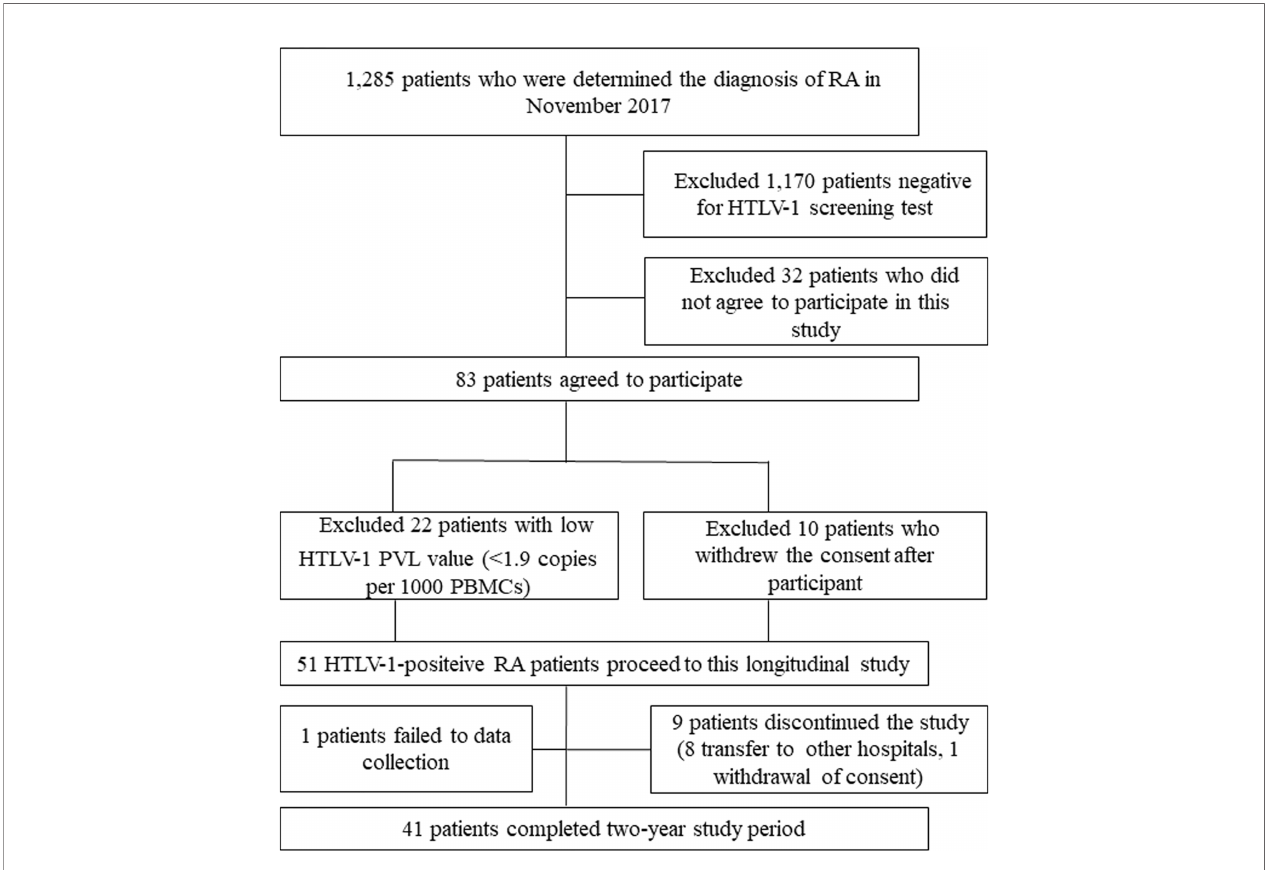
FIGURE 1 | Flowchart for study sample. RA , rheumatoid arthritis; HTLV-1 PVL , Human T-cell leukemia virus type 1 proviral load; PBMCs , peripheral blood mononuclear